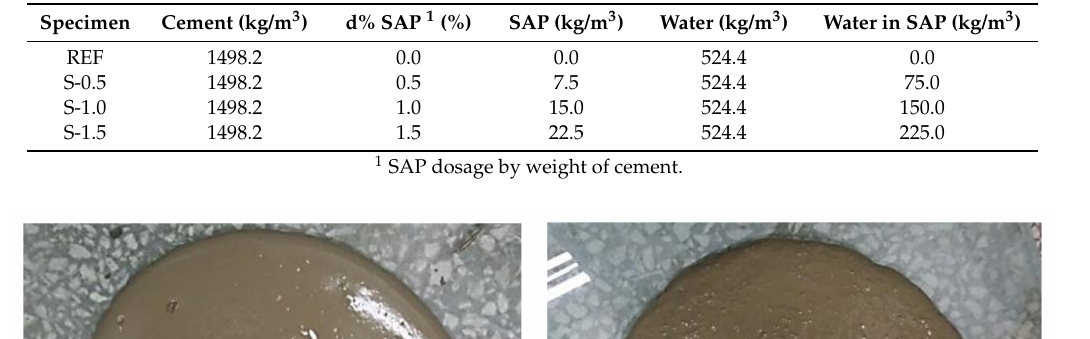
Table 2. Mixture proportion of cement paste specimens used in the test.